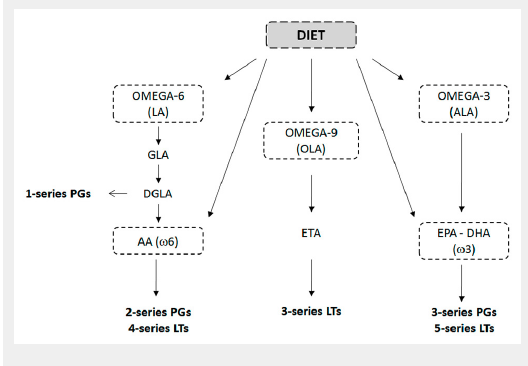
The influence of diet on prostaglandin and leukotriene production from polyunsaturated n-3 and n-6 fatty acids and monounsaturated n-9 fatty acids. AA = arachidonic acid; ALA = α-linolenic acid; DGLA = dihomo-γ- linolenic acid; DHA = docosahexaenoic acid; DPA = docosapentaenoic acid; EPA = eicosapentaenoic acid; ETA